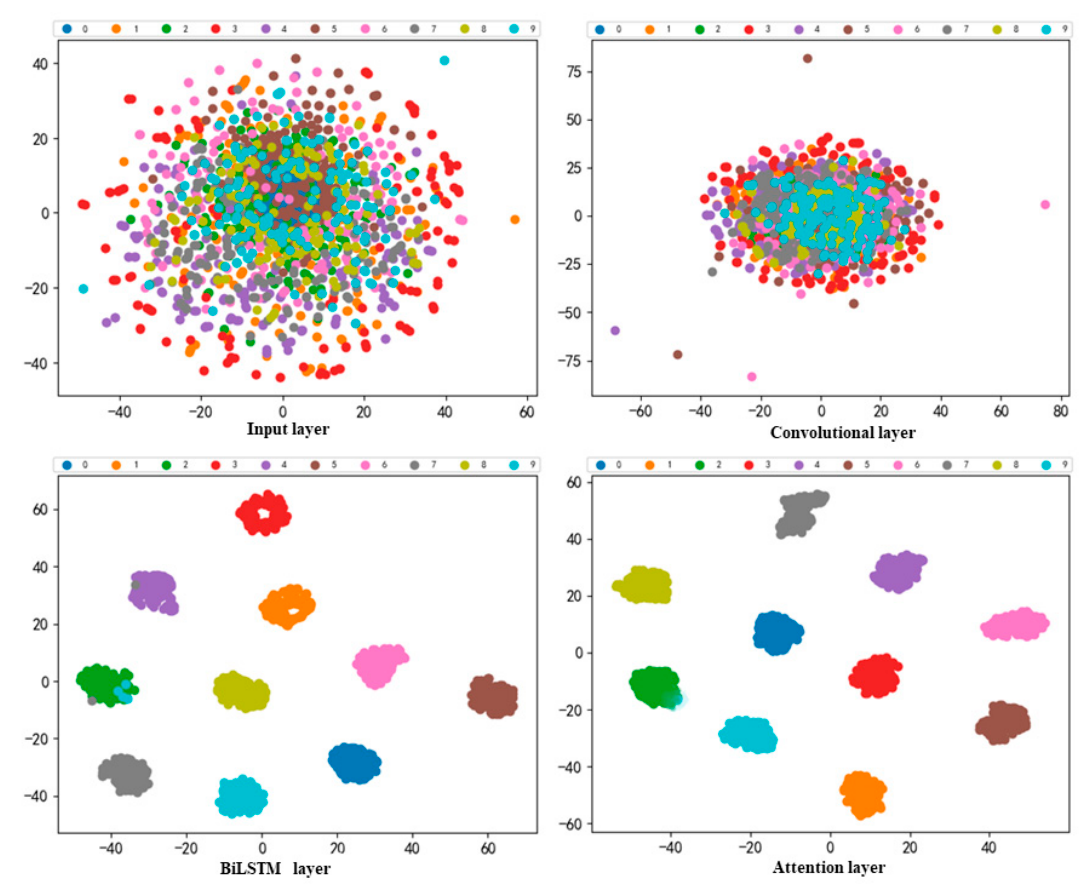
Figure 13. Visualization results of t-SNE for model feature extraction. Table 3. Comparison of the accuracy of the proposed model with other models in rolling bearing fault diagnosis for